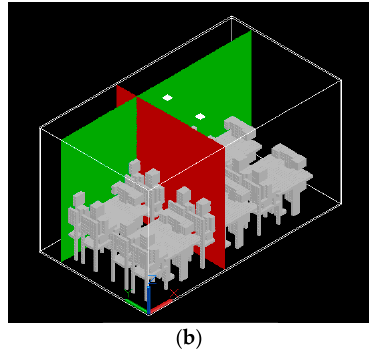
Figure 5. Three-dimensional arrangement for 6 occupants ( a ), X = 1.791 m (red plan) and Y = 0.63099 m (green plan) and 12 occupants ( b ), X = 1.791 m and Y = 0.4423 m.